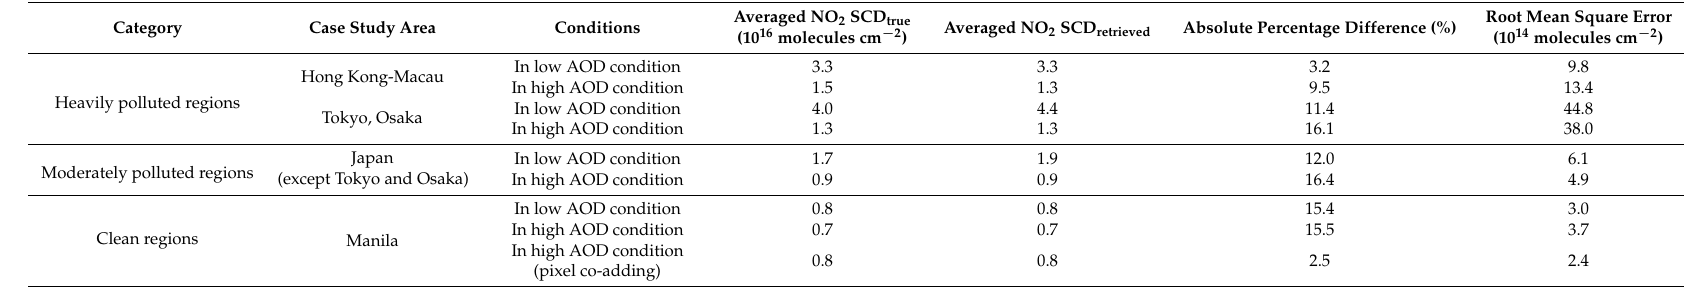
Table 3. Averaged NO 2 SCD true , Averaged NO 2 SCD retrieved , absolute percentage difference, and root mean square error in heavily polluted, moderately polluted, and clean region. (Slant column density (SCD) and aerosol optical depth